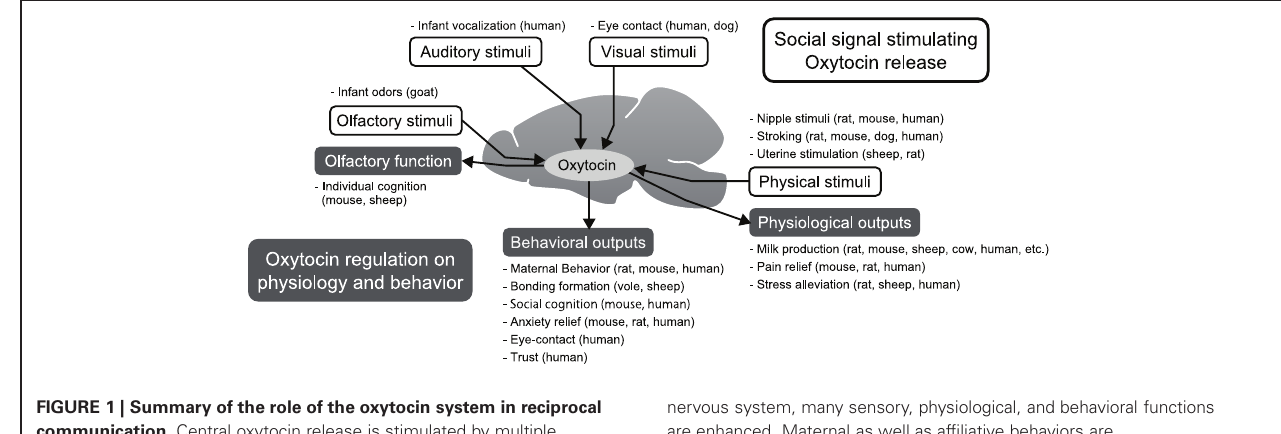
nervous system, many sensory, physiological, and behavioral functions are enhanced. Maternal as well as affiliative behaviors are enhanced by oxytocin. Additionally, negative responses, such as pain, stress endocrine, and anxiety behaviors are diminished by oxytocin.